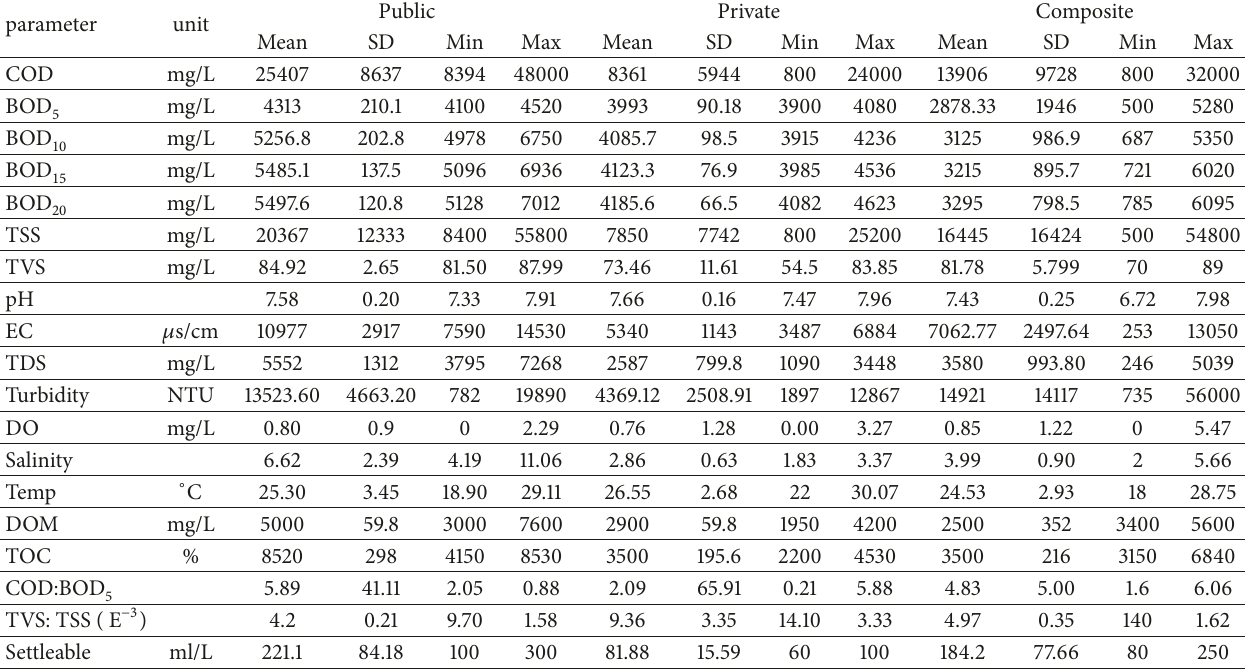
Table 1: Summary Analysis of Faecal Sludge Characteristics (Number of samples = 6,000 trucks).